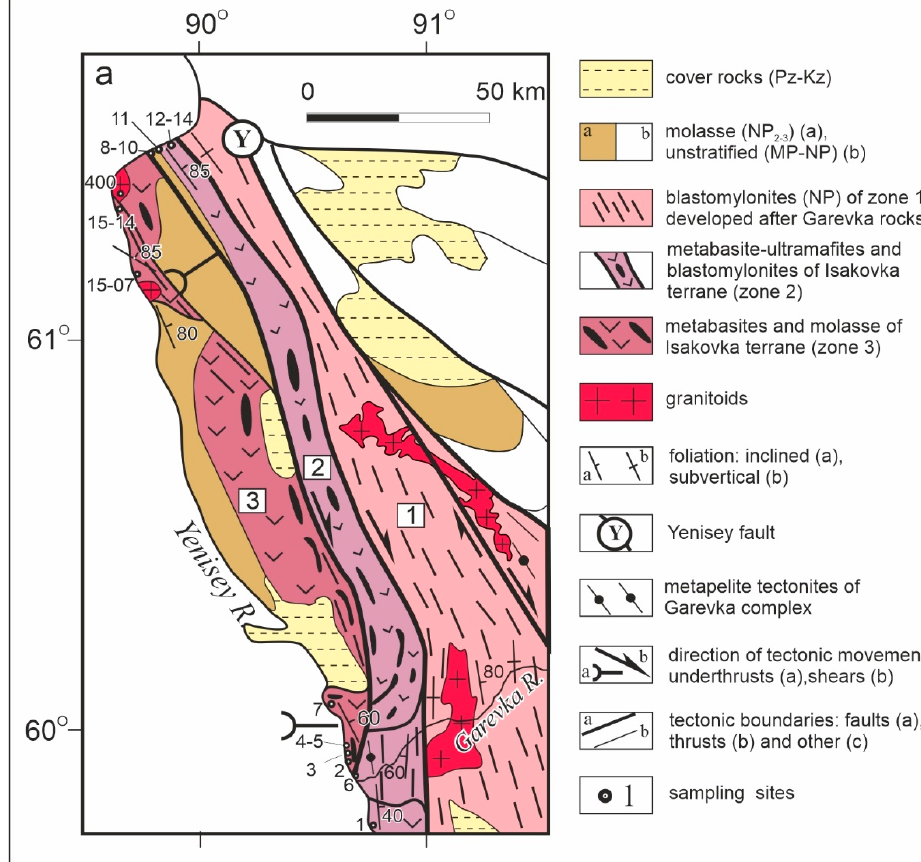
Figure 3. Sketch map showing the location of the Yenisey regional shear zone within the Northern Yenisey Ridge; the Arabic numerals in squares denote three major lithological units in the YRSZ structure: gneiss-amphibolite (1), metabasite-ultramafic (2), and volcanic-plutonic (3).